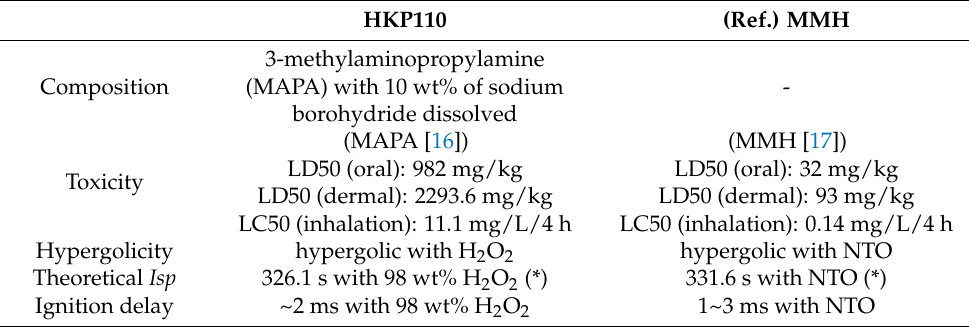
Table 1. The details of HKP110 fuel.